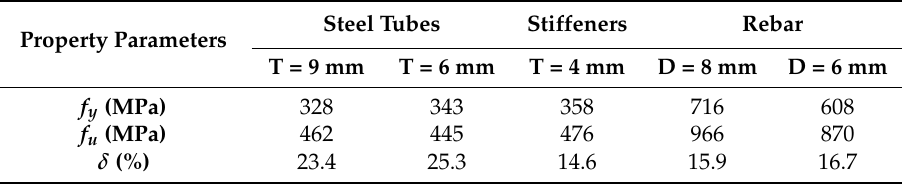
Table 2. Mechanical properties of steel.